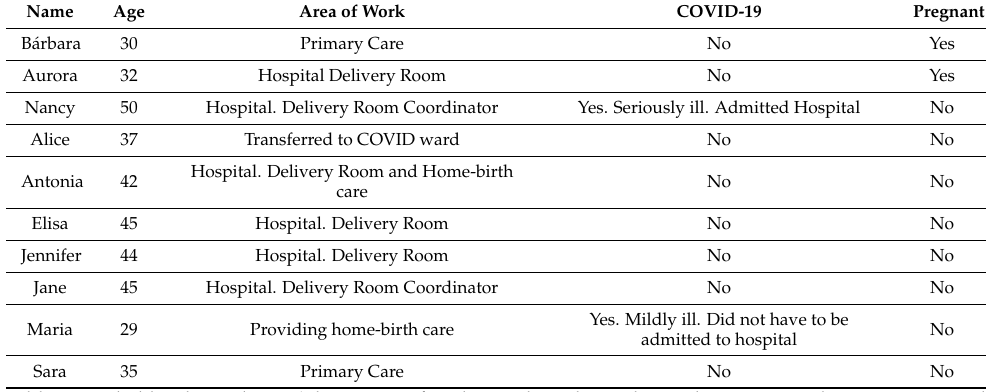
Table compiled by the authors. (The names of midwives have been changed to preserve the anonymity and confidentiality of the